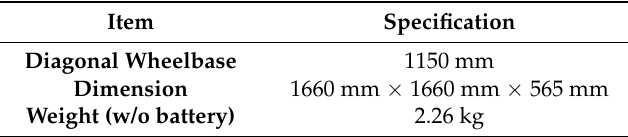
Table 4. Specifications of the UAV.